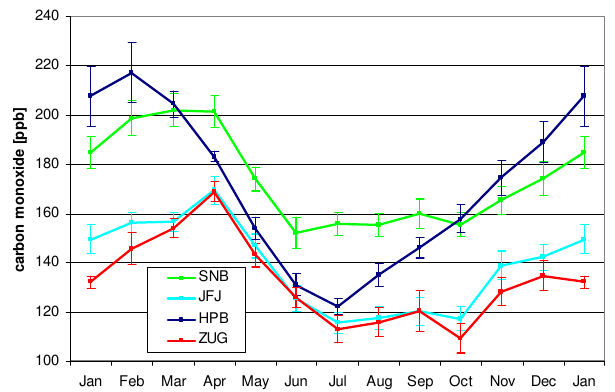
Fig. 8. CO mean annual variation at the “DACH”-sites, blue: HPB; red: ZUG, light blue: JFJ, green: SNB. Error bars indicate the stan- Figure.8. CO mean annual variation at the „DACH“-sites, blue: HPB; red: ZUG, light blue: 3 dard error of the JFJ, green: SNB. Error bars indicate the standard error of the mean. 4